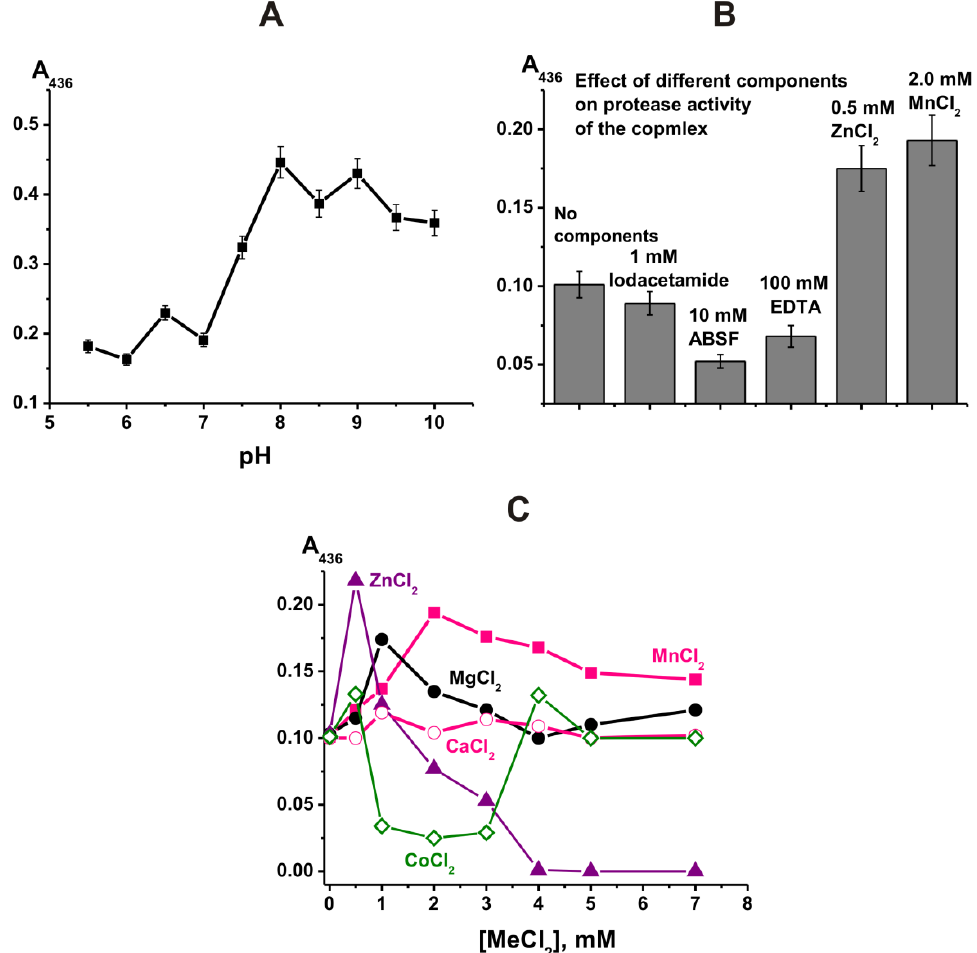
Figure 1. Dependence of the efficiency of azocasein (3.3 mg/mL) hydrolysis (A 436 ) by a stable complex (0.025 mg/mL or ~1.25 × 10 − 8 M) on the pH of the reaction medium ( A ). Effect of preincubation of a stable complex with specific inhibitors of thiol (iodoacetamide), serine (ABSF), and metalloproteases (EDTA), as well as ZnCl 2 and MnCl 2 , on its activity in the hydrolysis of azocasein ( B ). Dependence of the efficiency of azocasein hydrolysis on concentrations of different metal ions ( C